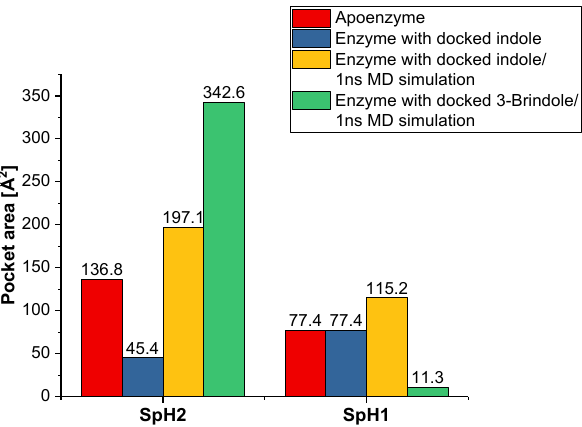
Figure 5. Active site pocket area for the apo-, indole-, and 3-bromoindole-docked SpH2 and SpH1 halogenases, showing the flexibility of SpH2 in accommodating 3-bromoindole, unlike SpH1.